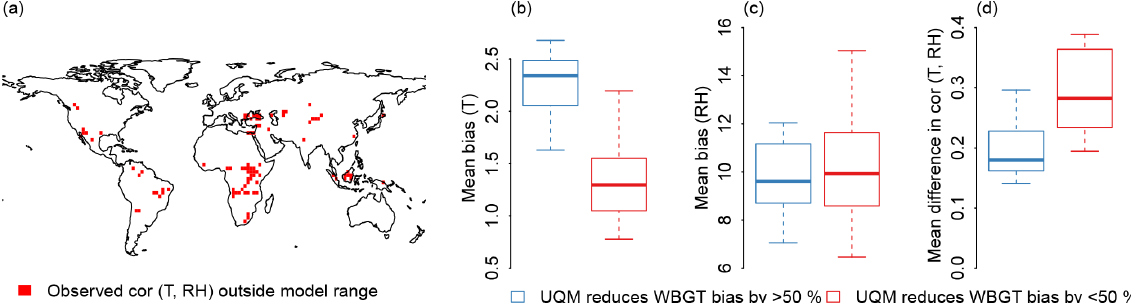
Figure 6. Reasons why UQM may fail. (a) Regions in which the correlation between temperature and relative humidity in ERA-Interim is outside the CMIP5 model range; (b–d) conditions where UQM does not lead to a substantial reduction in biases in WBGT (measured as difference in empirical cumulative distribution function RMSE between model output and ERA-Interim before and after bias adjustment). Shown is the mean bias in temperature ( T , b ) and relative humidity (RH, c ) as well as the mean difference in correlation over all grid cells between temperature and relative humidity (d) . Blue (red) represents the distribution across models for cases in which UQM does (does not) lead to a reduction in biases of WBGT by at least 50%.